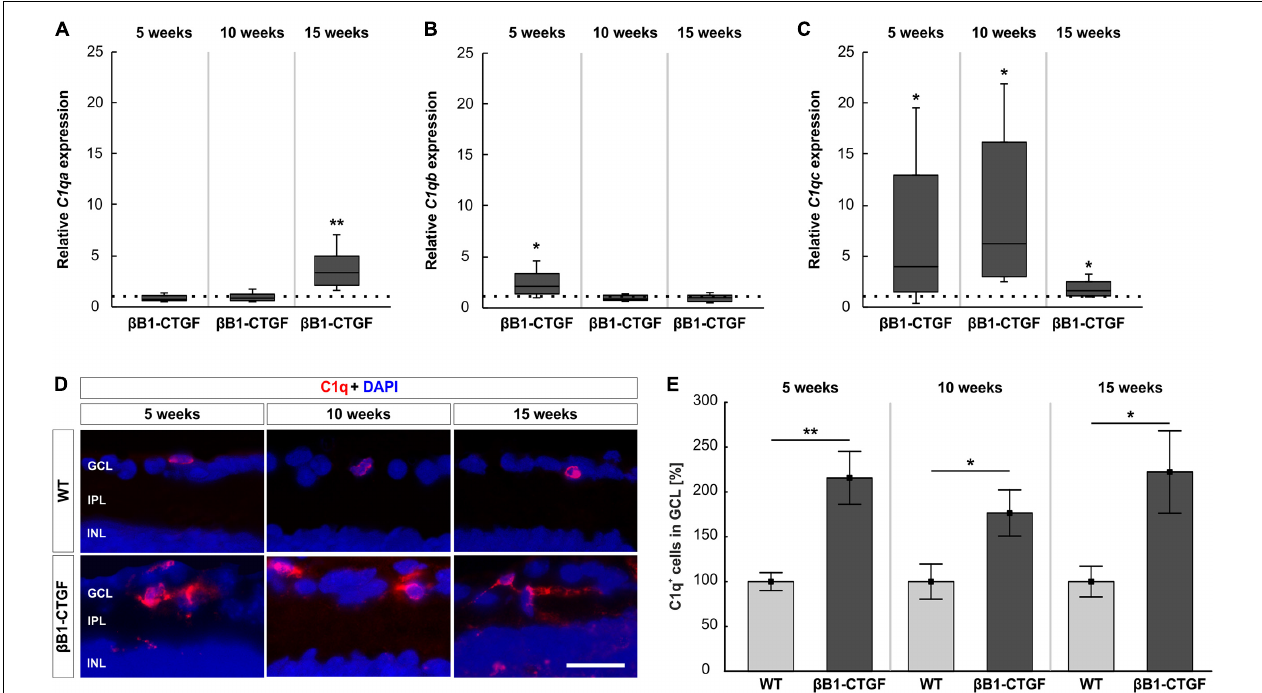
FIGURE 4 | C1q upregulation in transgenic animals. (A) RT-qPCR analyses revealed no alterations in C1qa mRNA levels in β B1-CTGF mice at 5 and 10 weeks. At 15 weeks, a significant upregulation of C1qa mRNA levels was seen ( p = 0.005). (B) At 5 weeks, C1qb mRNA levels were significantly upregulated ( p = 0.04), while no changes were noted at 10 and 15 weeks. (C) The mRNA levels of C1qc were significantly upregulated in transgenic mice at 5 ( p = 0.04), 10 ( p = 0.01), and 15 weeks of age ( p = 0.03). (D) Retinal cross-sections were labeled with an antibody against C1q (red), while DAPI counterstained cell nuclei (blue) in 5-, 10-, and 15-week-old mice. (E) The number of C1q + cells in the ganglion cell layer was significantly higher in β B1-CTGF and WT animals at 5 ( p = 0.003), 10 ( p = 0.04), and 15 weeks ( p = 0.03). Values for RT-qPCR are median ± quartile ± minimum/maximum ( n = 5–7/group). The dotted line in panels (A–C) represents the relative expression of the WT group. Values for immunohistology are mean ± SEM ( n = 7–9/group). GCL, ganglion cell layer; IPL, inner plexiform layer; INL, inner nuclear layer. Scale bar: 20 µ m. * p < 0.05, ** p <